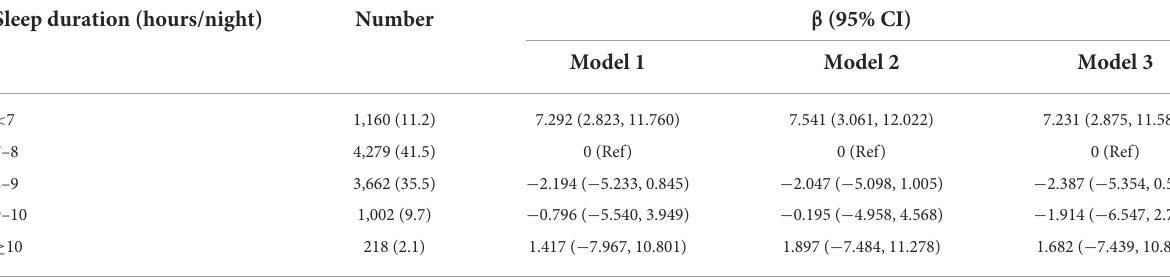
TABLE 2 Association between nocturnal sleep duration and serum uric acid